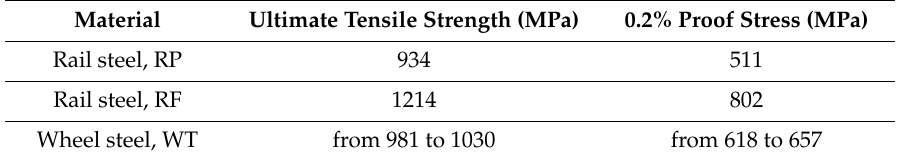
Table 2. Mechanical properties.